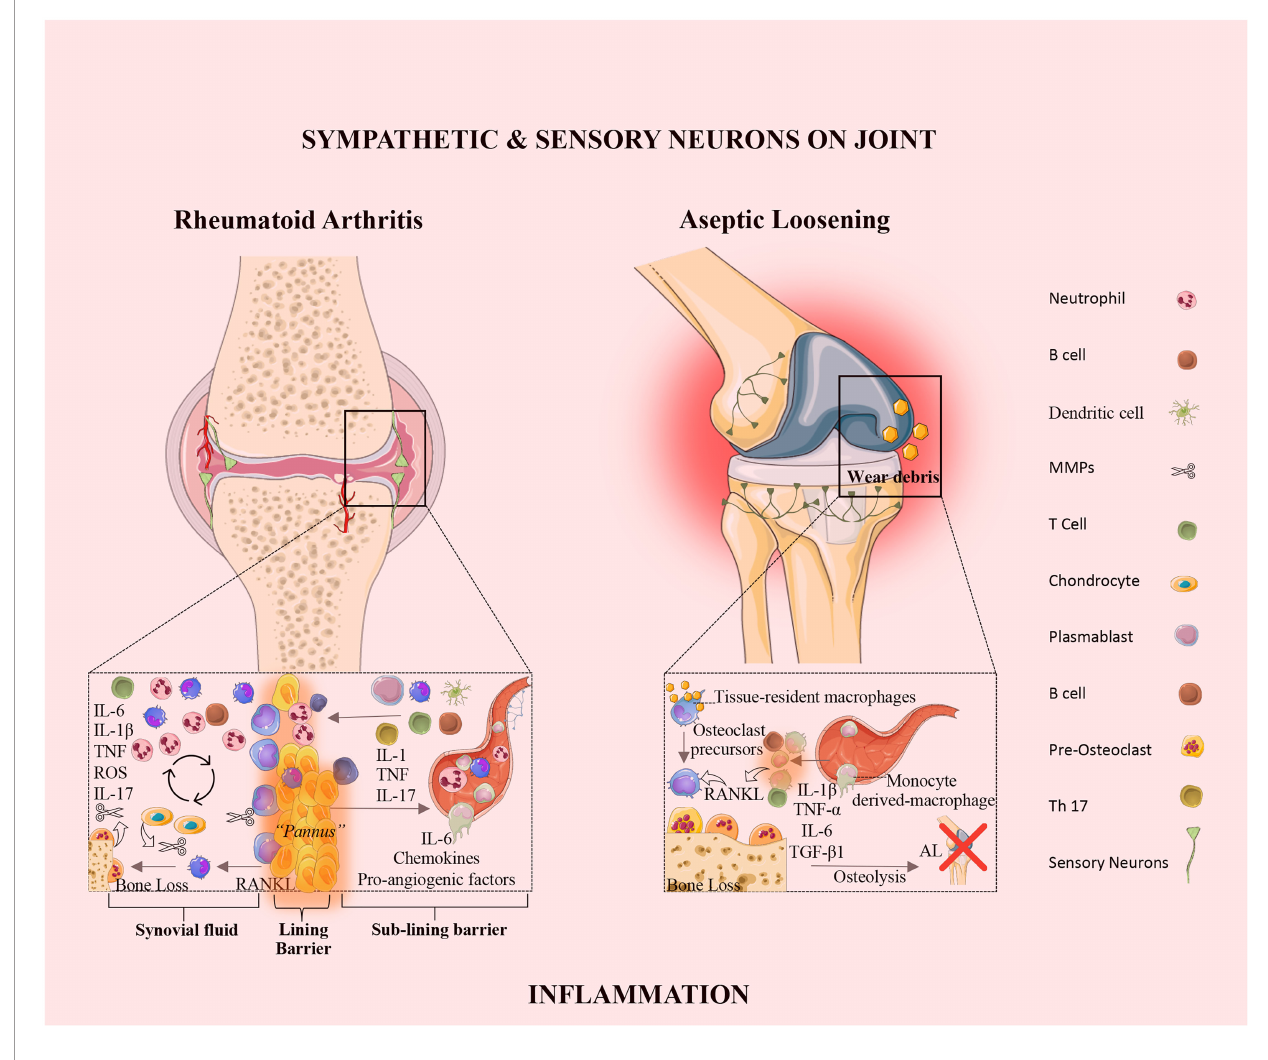
FIGURE 2 | The synovial joint in rheumatoid arthritis and aseptic loosening. Rheumatoid Arthritis: In RA, the synovial intimal lining expands and forms an invasive hyperplastic pannus and sensory innervation increases, and sympathetic innervation is lost. The vicious cycle mediated by the interactions shown between immune cells, synovial fi broblasts, chondrocytes, and osteoclasts, together with the molecular products of damage, drive the chronic phase in the pathogenesis of RA. Aseptic loosening: In AL, wear particles released from implant devices and accumulated around the bone-implant interface, induce the release of pro-in fl ammatory mediators by tissue-resident macrophage. The innervation pro fi le in AL is characterized by the rearrangement of sensory neurons and the absence of sympathetic fi bers. IL, interleukin; TNF, tumor necrosis factor; ROS, reactive oxygen species; RANKL, receptor activator of nuclear factor kappa-B ligand; TGF, transforming growth factor; AL, aseptic loosening; Th,